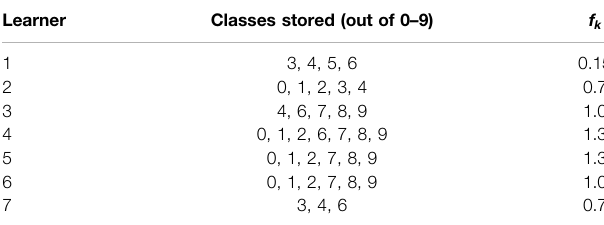
TABLE 2 | The non-IID distribution of data among learners, and their computational coef fi cients f k . Learner Classes stored (out of 0 –